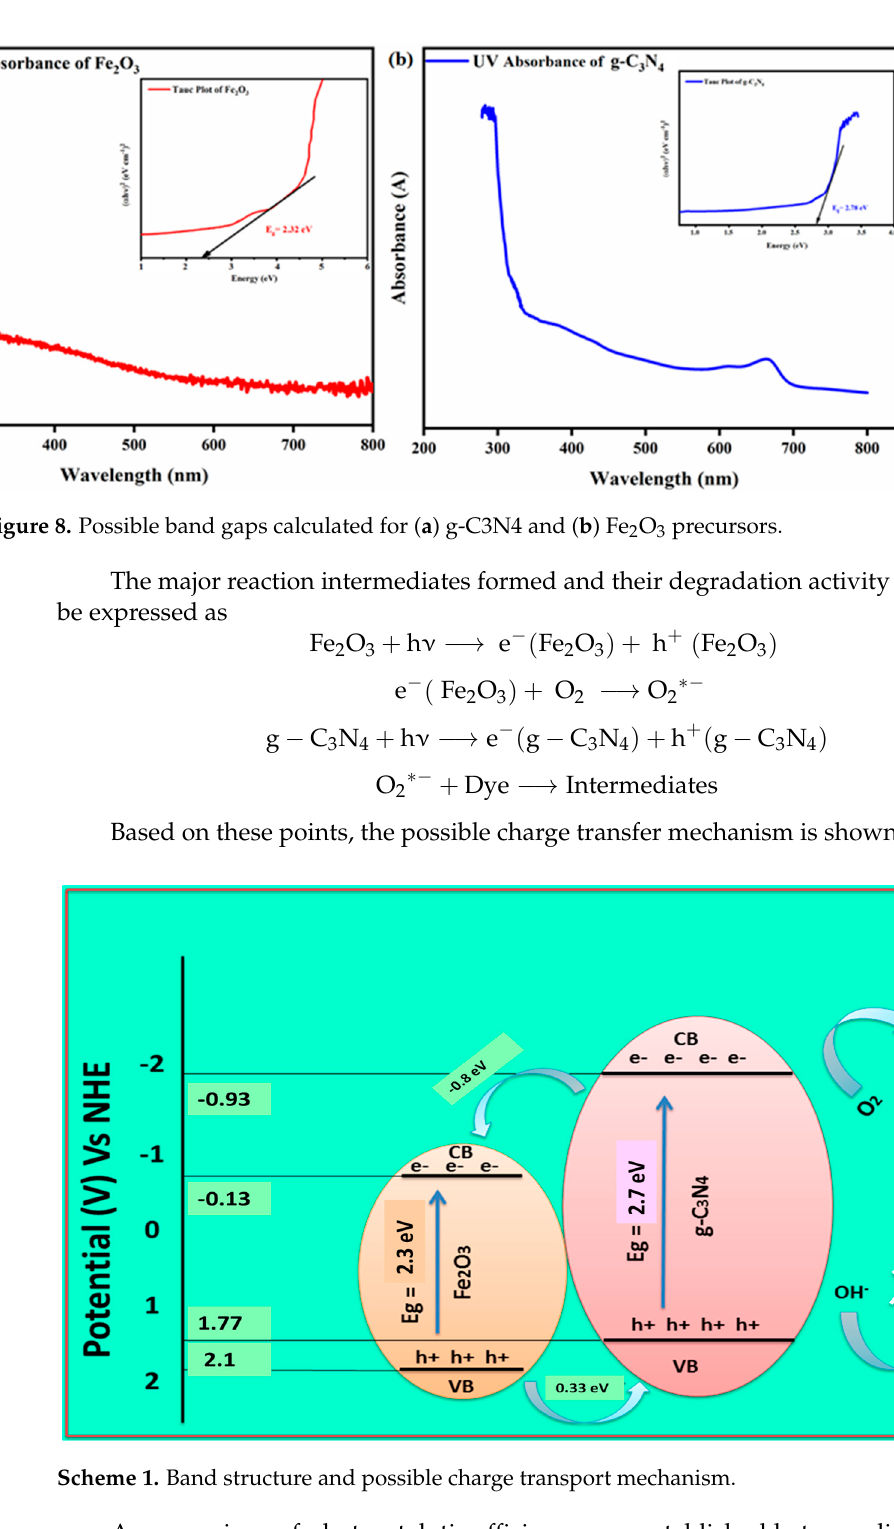
Table 2. Comparative effectiveness of various photocatalysts in the photo-degradation of rhodamine B and methylene blue.